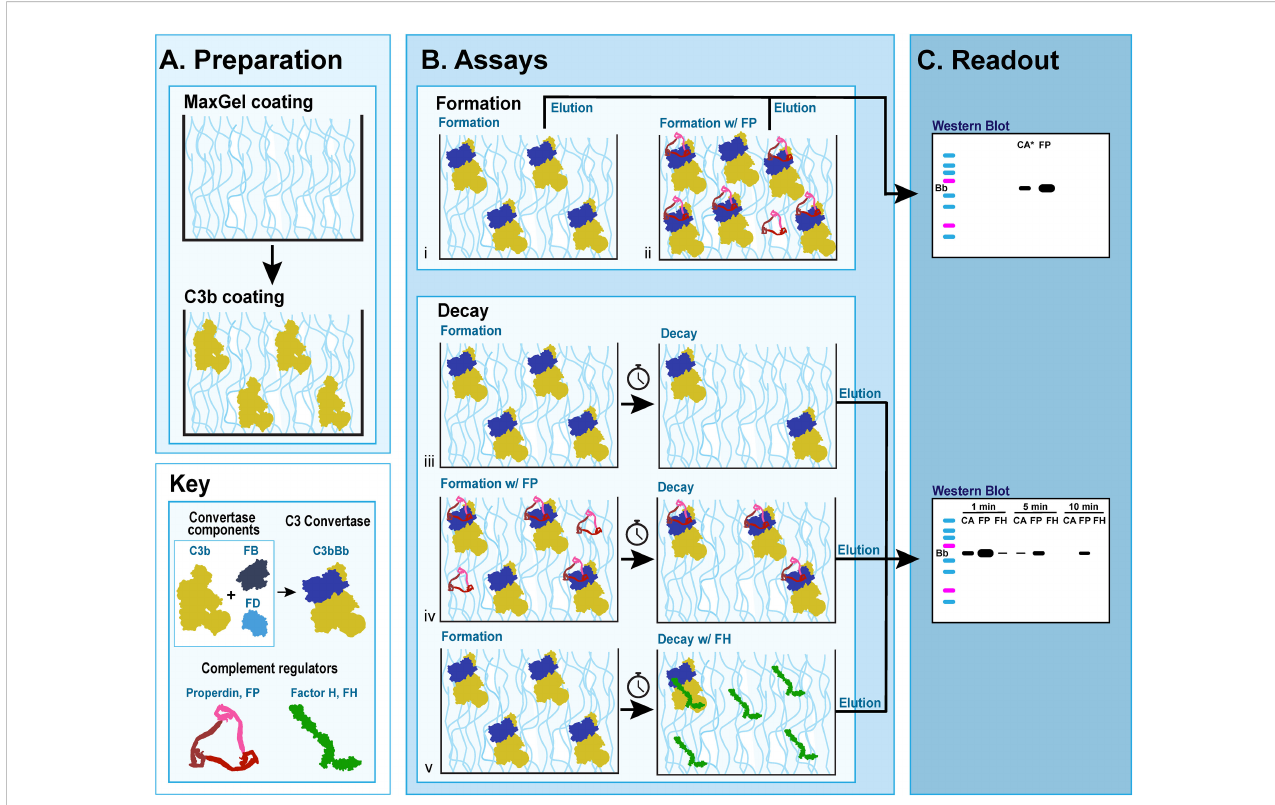
FIGURE 2 C3 convertase assays on MaxGel surface. (A) Preparation for all assays involves coating microtiter plates with MaxGel (ECM) followed by coating with C3b. (B) Formation assay: Factor B (FB) and Factor D (FD) are added to C3b-coated MaxGel, subsequently generating C3bBb over the course of 10 min in the absence (i) or presence (ii) of Properdin. Decay assay: C3bBb is generated as described above in absence (iii, v) or presence of Properdin (iv), and then allowed to decay over time naturally (iii, iv) or in presence of Factor H (v). (C) The amount of C3 convertase present on MaxGel surface at the time of elution is quantitated by western blot and observing the Bb complement